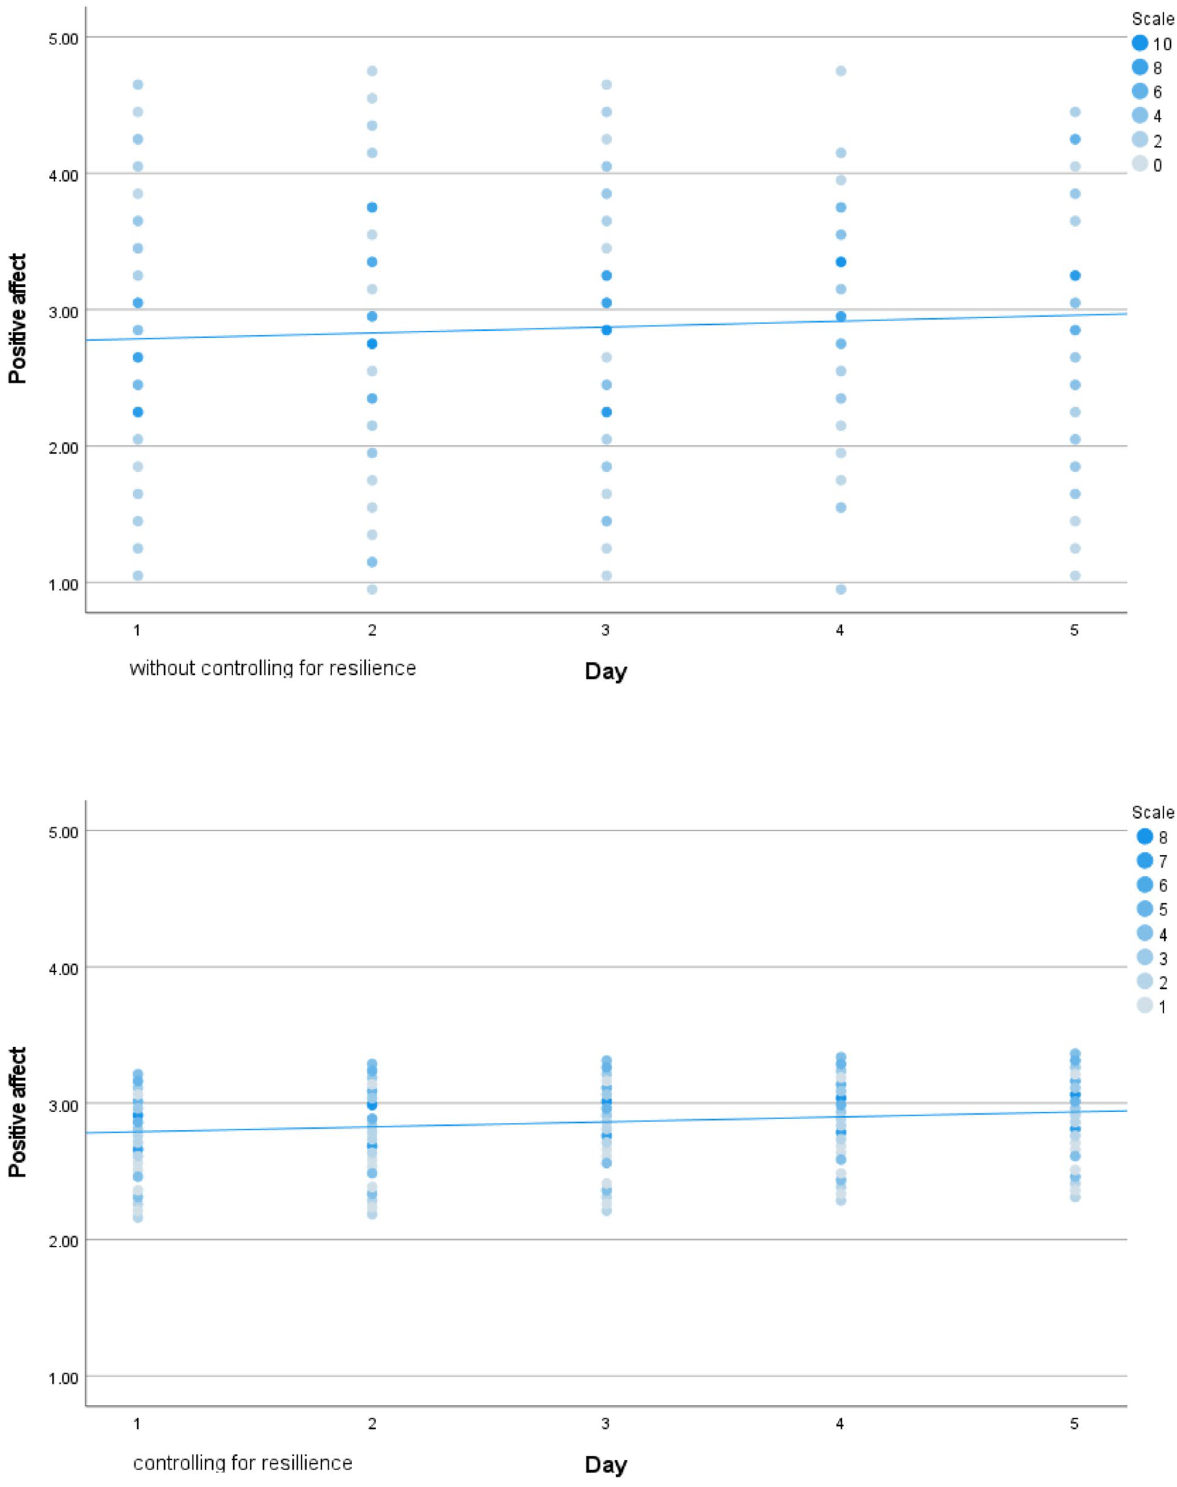
Figure 1. Variance in positive affect in five consecutive days without and with controlling for baseline resilience